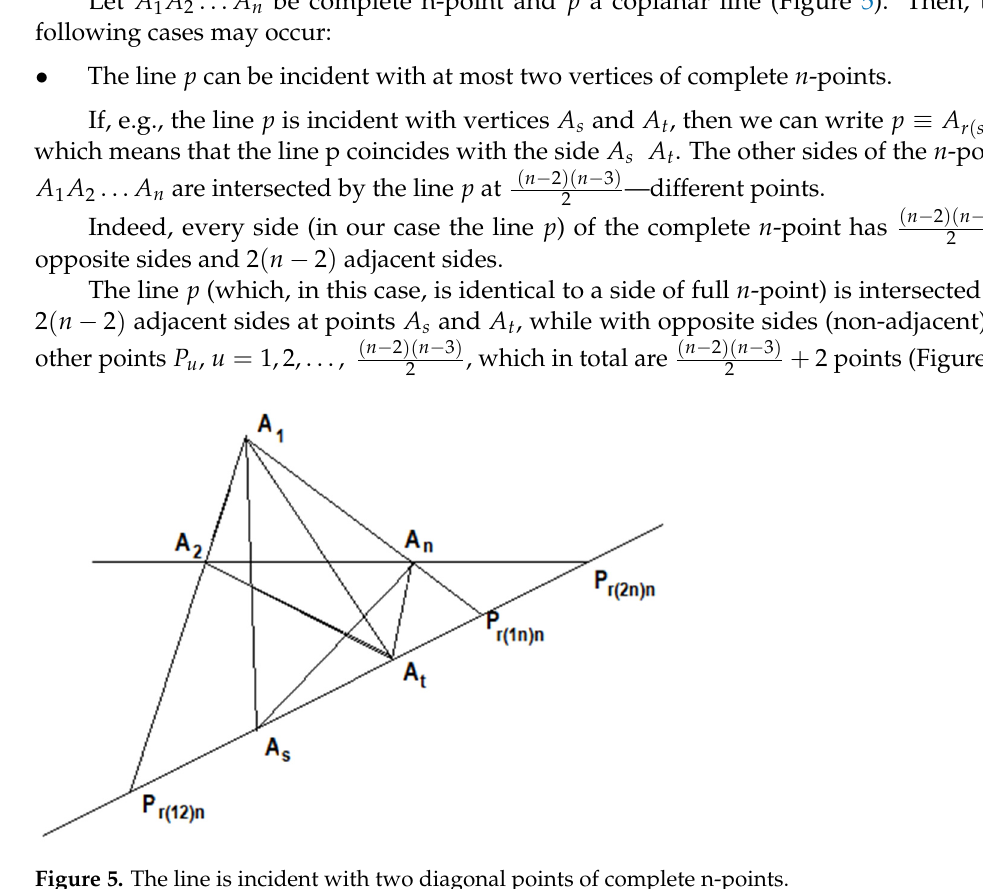
Figure 5. The line is incident with two diagonal points of complete